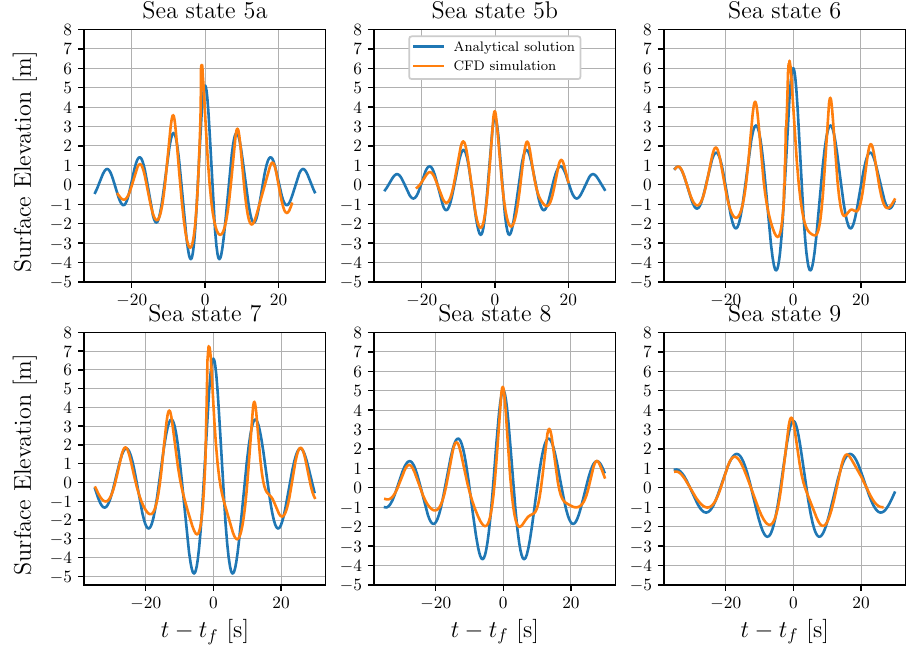
Figure 9. Focused wave propagation at the focal point as given by the analytical solution and the numerical simulation. The analytical solution is based on NewWave theory, while CFD simulations calculate the wave propagation in a two-dimensional numerical wave